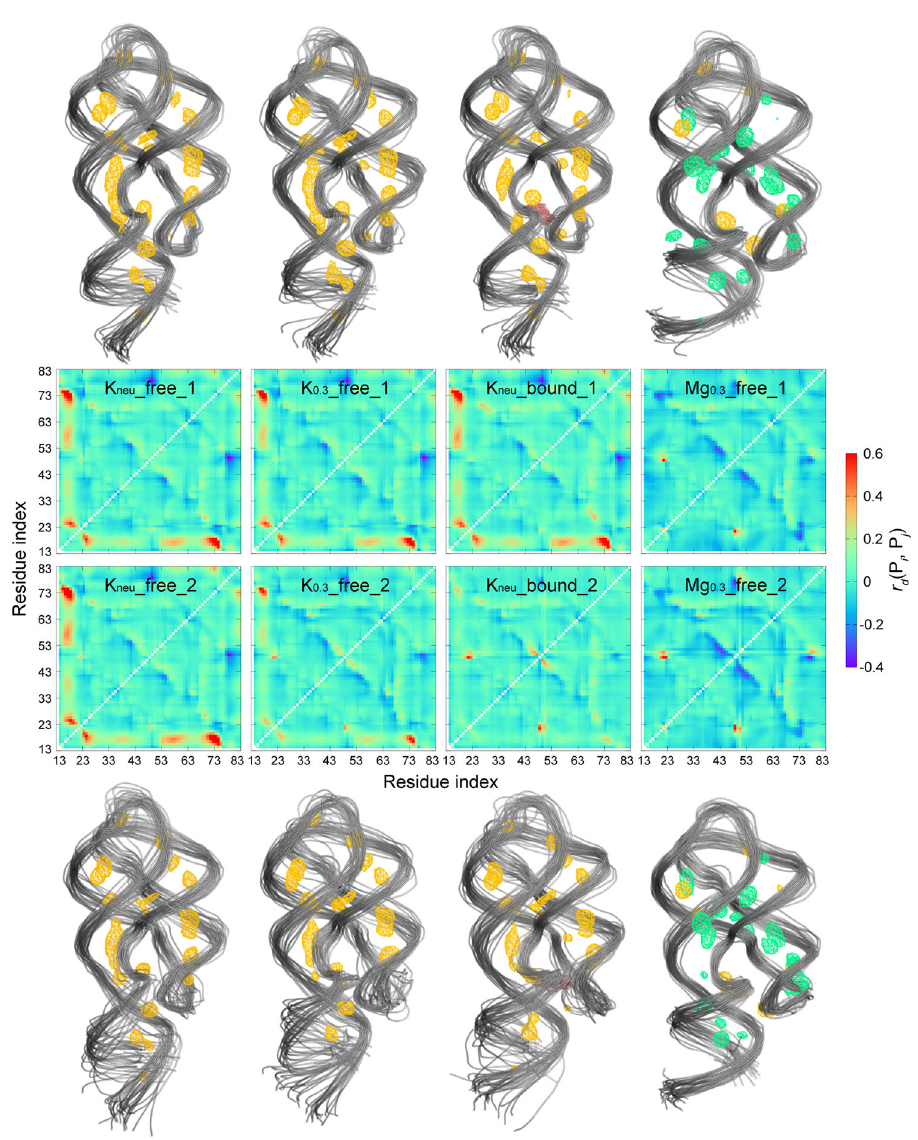
Fig. 2 The structural features of AARA in different ionic environments and the metal ion distribution around it. The change ratio r Δ d (P i , P j ) of the average distance between every two phosphate groups relative to that in crystal structure for all eight simulation trajectories. The color bar shows the variations in r Δ d (P i , P j ) from − 0.4 (dark blue) to 0.6 (red). The structure clusters of AARA and speci fi c binding sites of metal ions around it in all eight simulation trajectories (all of 1.2 μ s data). Here, the sampling interval for generating structure clusters is 40 ns (30 conformations in total). The speci fi c binding sites are described by the spatial occupancies of metal ions with an isosurface of 0.1 Å − 3 (K + in orange and Mg 2 + in green). The time-averaged spatial occupancies of metal ions were converted into density maps using the VolMap tool of the VMD molecular visualization program, and we chose a resolution of 0.5 Å 3